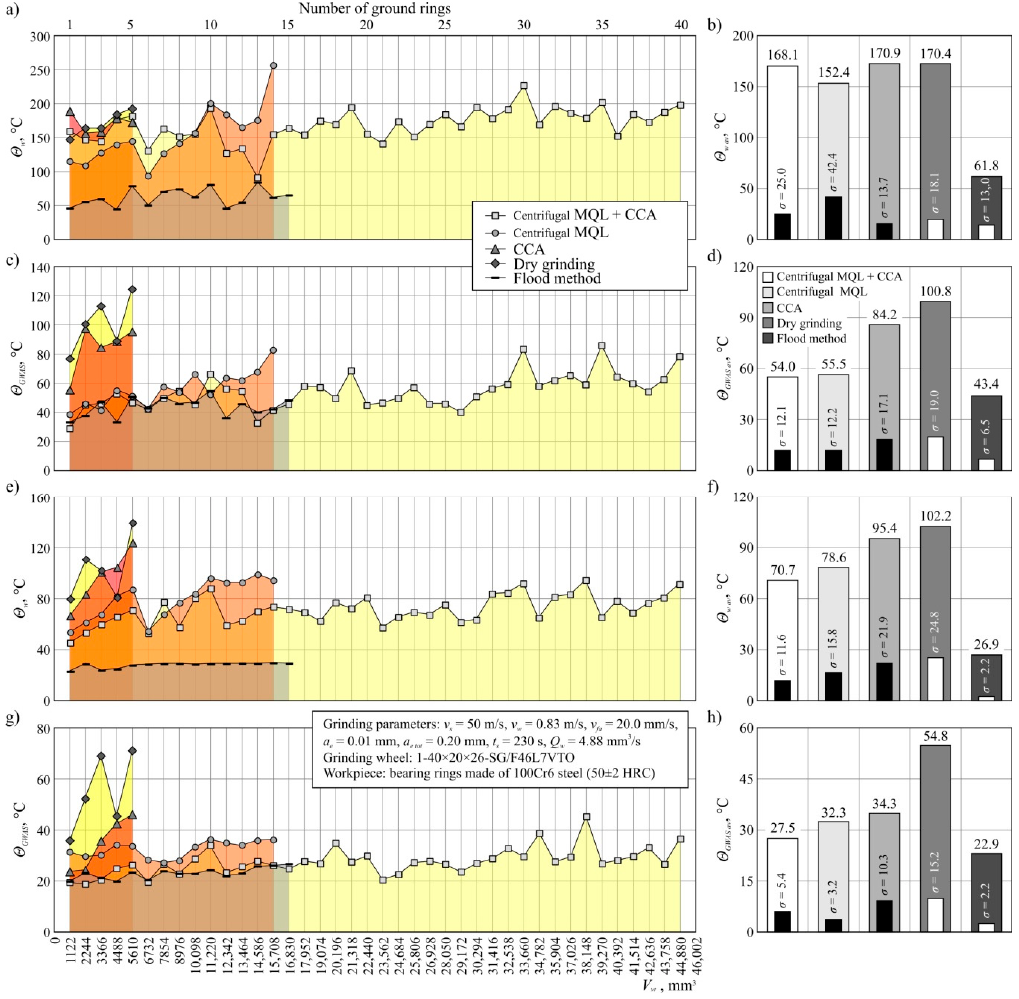
Figure 5. Workpiece and grinding wheel temperature measured during the grinding process ( a – d ) and immediately after the grinding process ( e – h ): ( a , e ) workpiece temperature Θ w ; ( b , f ) average workpiece temperature Θ w av with the standard deviation σ ; ( c , g ) grinding wheel temperature Θ GWAS ; ( d , h ) average grinding wheel temperature Θ GWAS av with the standard deviation σ .